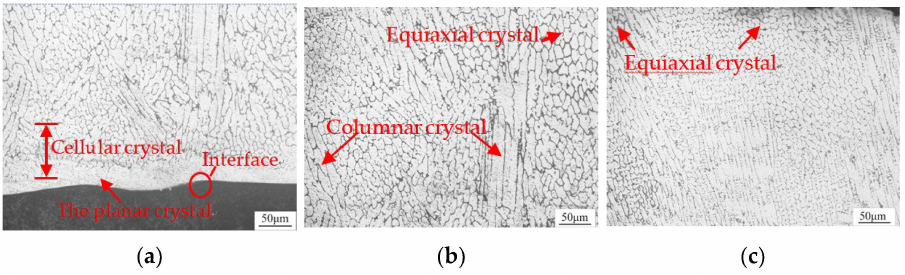
Figure 10. OM morphology of the cladding layer; ( a ) bottom of cladding layer; ( b ) middle part of cladding layer; and ( c ) upper part of cladding layer.